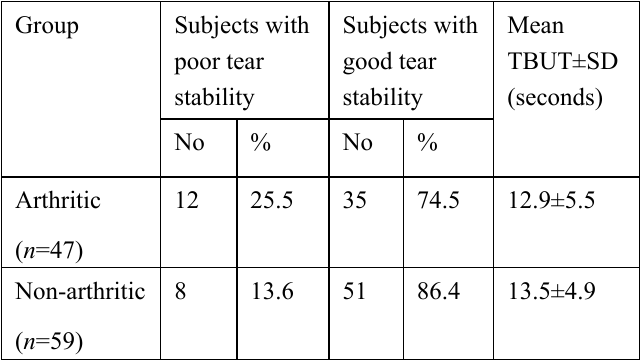
Table 3: Subjects with poor tear